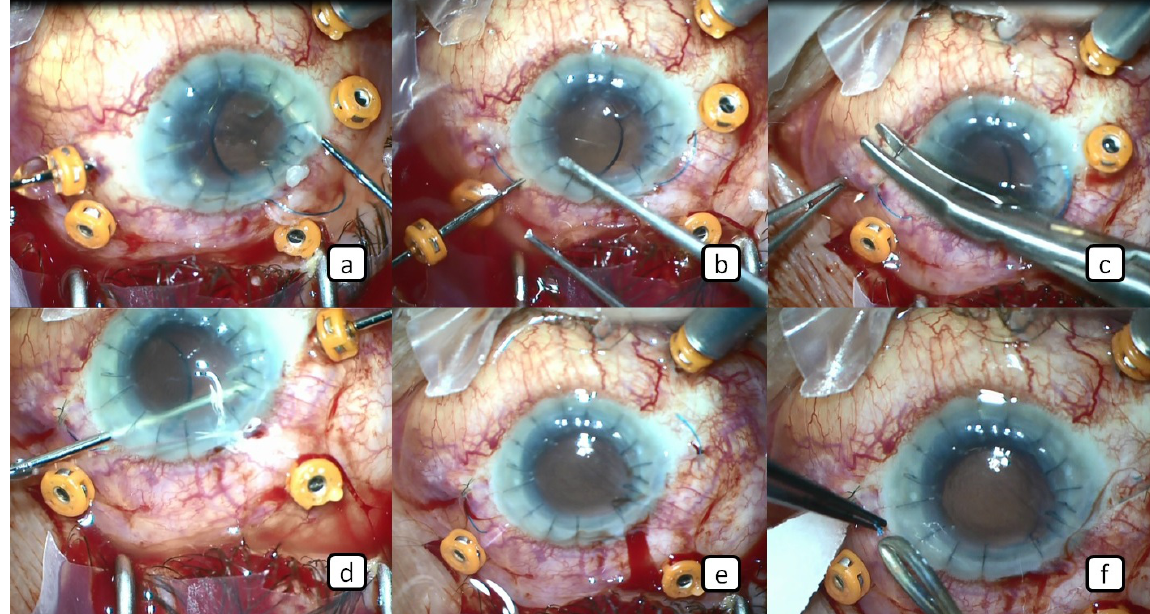
Figure 2: a) The tip of one of the IOL haptics is grasped with a 23-gauge serrated retinal forceps. b) The haptic is removed from the scleral tunnel together with the trocar out of the globe. c) A transconjunctival safety 10-0 nylon suture was placed at the scleral tunnel entry site. d) The tip of the other haptic is grasped a forceps. e) Appearance of the haptics that are removed from the scleral tunnel. f) The end of the haptic is cauterized to make a